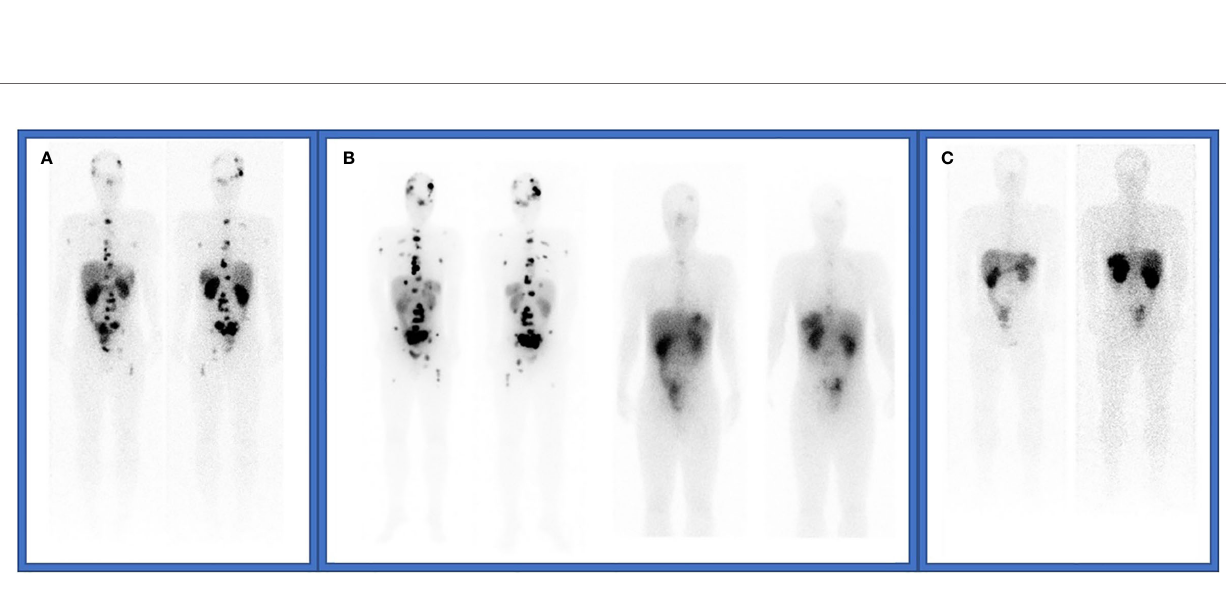
FIGURE 2 | (A) Octreoscan imaging at tumor recurrence in June 2019. (B) SPECT-CT studies after fi fth and sixth 177Lu-DOTATATE doses. (C) Octreoscan imaging after complete 177Lu-DOTATATE